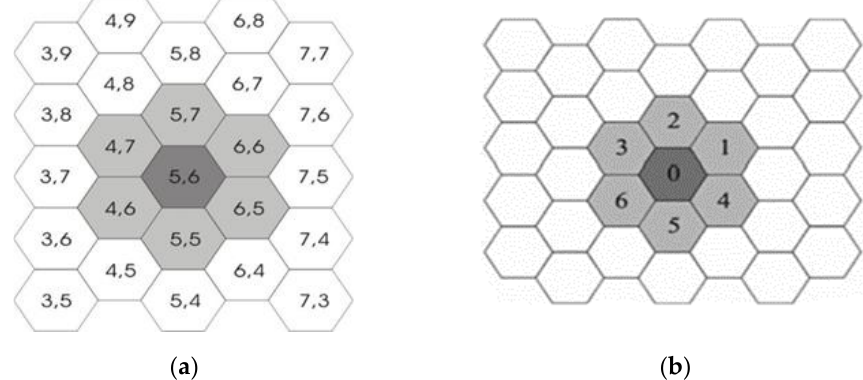
Table 1. Sub-states.